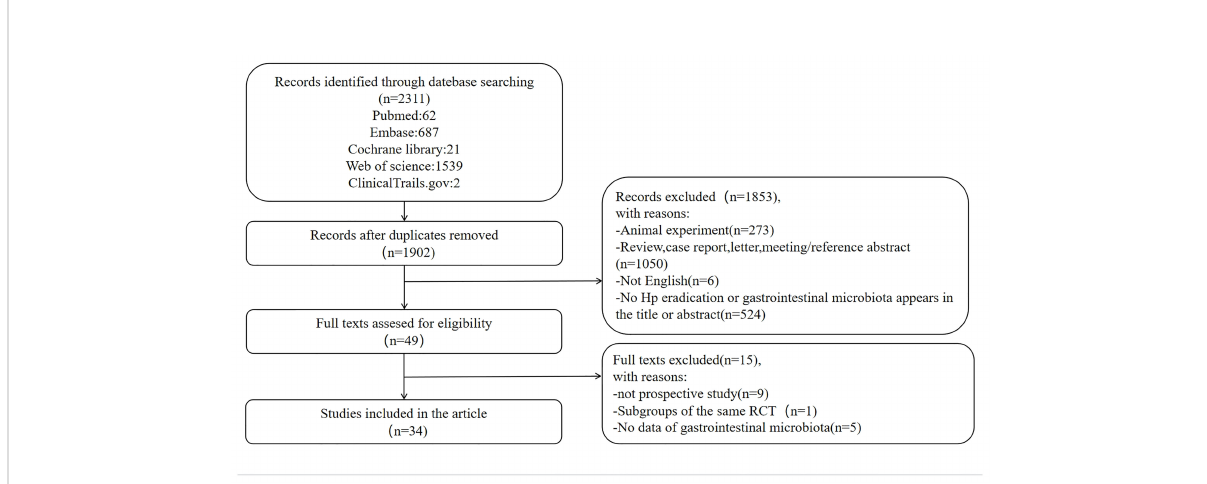
FIGURE 1 Literature screening fl